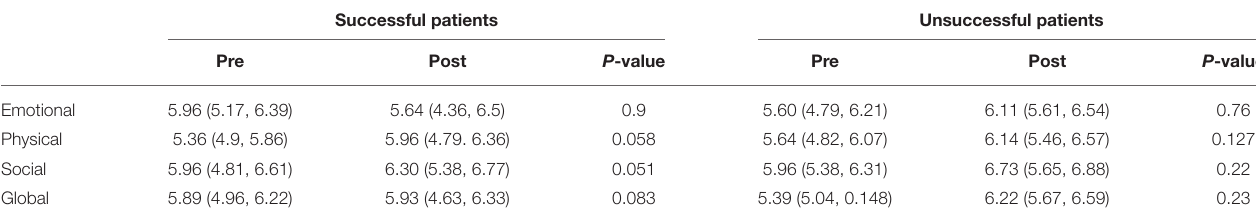
TABLE 4 | Changes in MacNew quality of life measures.